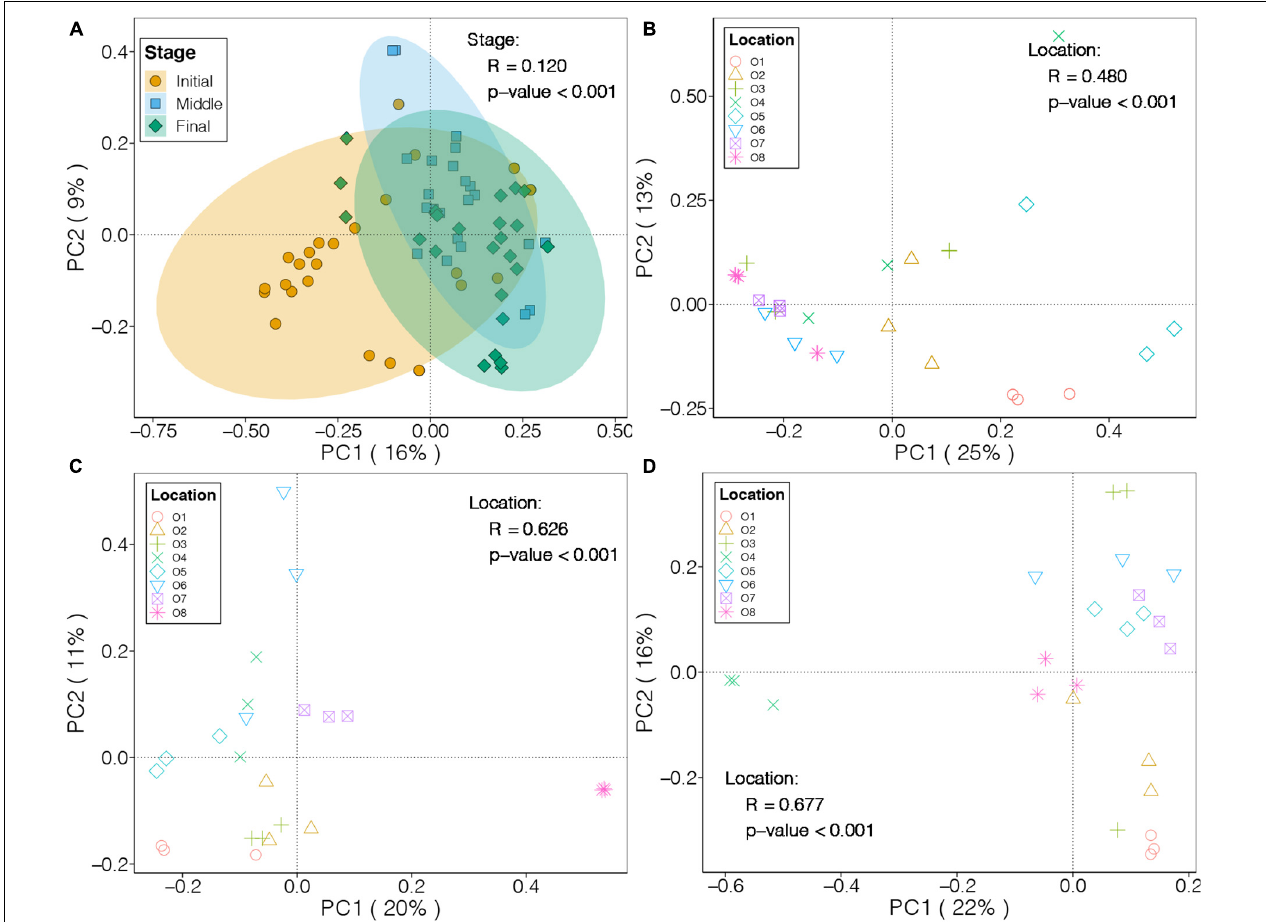
FIGURE 2 | PCoA and PERMANOVA results for the benthic bacterial communities in the purification area of the IPRS during (A) the culture cycle and (B–D) each culture stage ( B , initial; C , middle; and D , final).